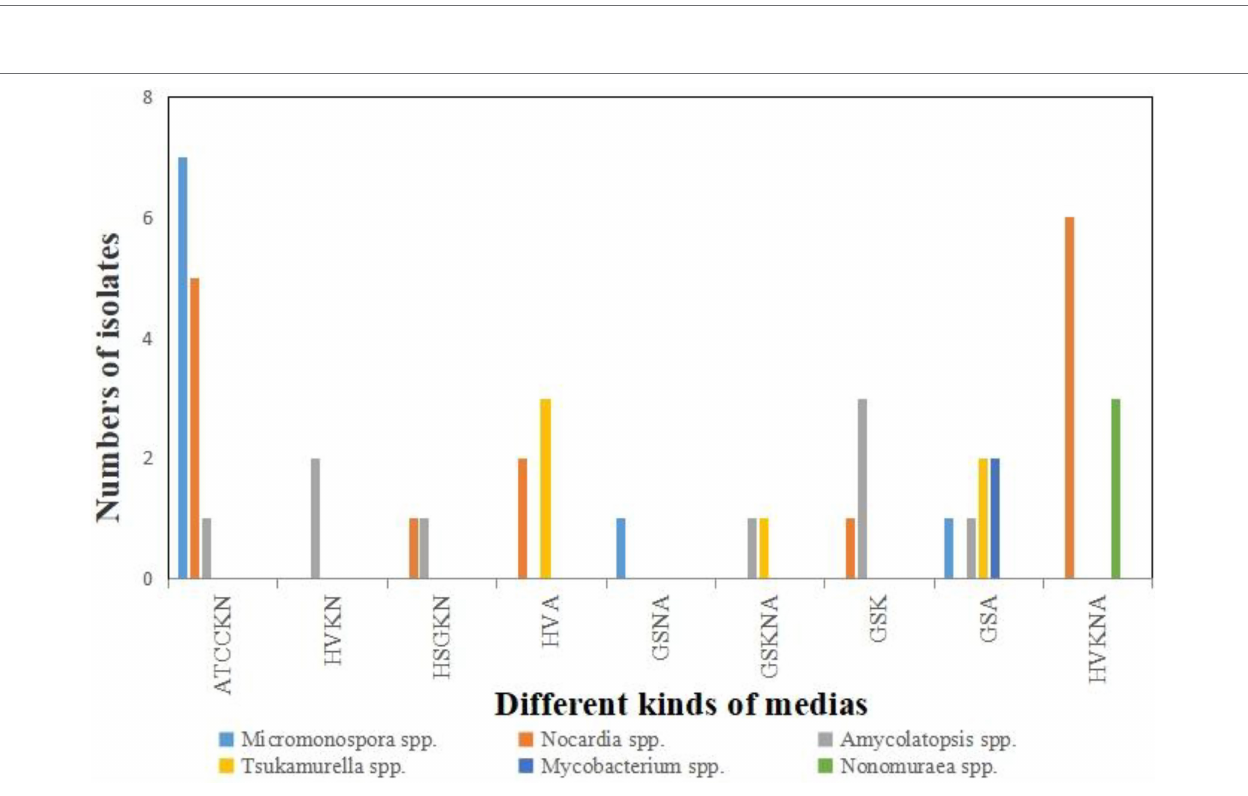
FIGURE 11 | The number of isolates in each species of Streptomyces . The taxonomic classification of the isolates was predicted using the most related 16S rRNA gene.